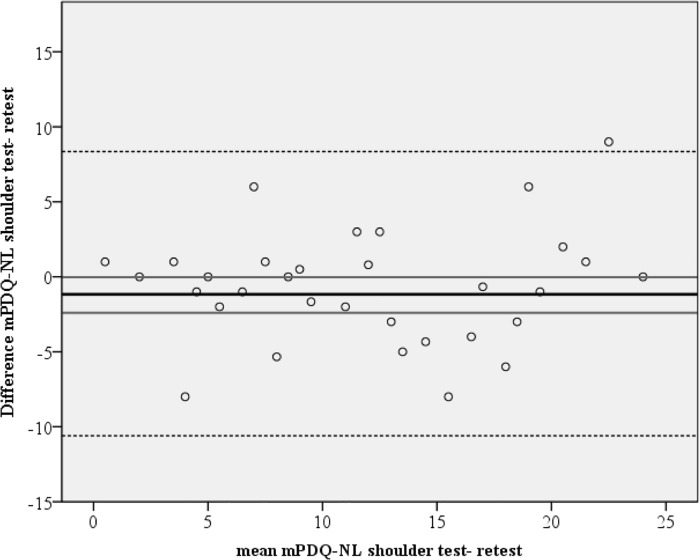
Bland Altman plot.Bland Altman plot with 95% confidence interval (CI). Vertical axis: difference between mPDQ-NL Shoulder test and retest. Horizontal axis: mean mPDQ-NL Shoulder when combining test and retest. The black horizontal line represents the mean difference between test and retest. The gray lines represent the 95% CI of this mean difference of the mPDQ-NL Shoulder. The dotted lines represent the limits of agreement.